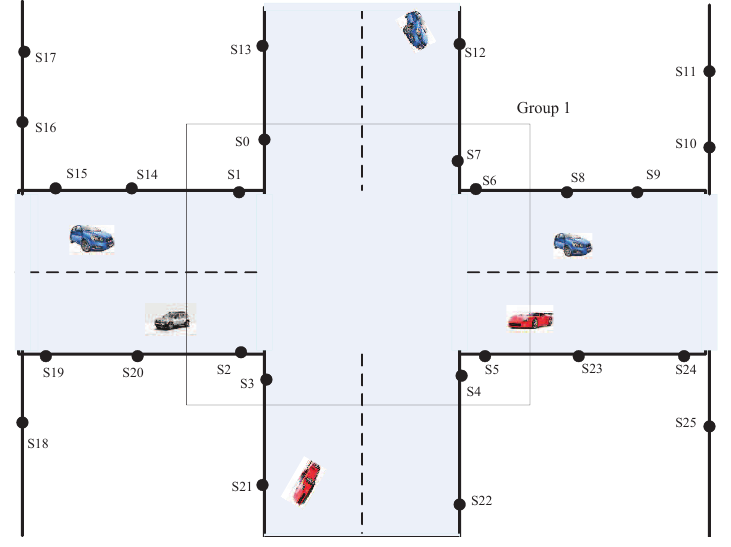
Figure 1. Intersection with wireless